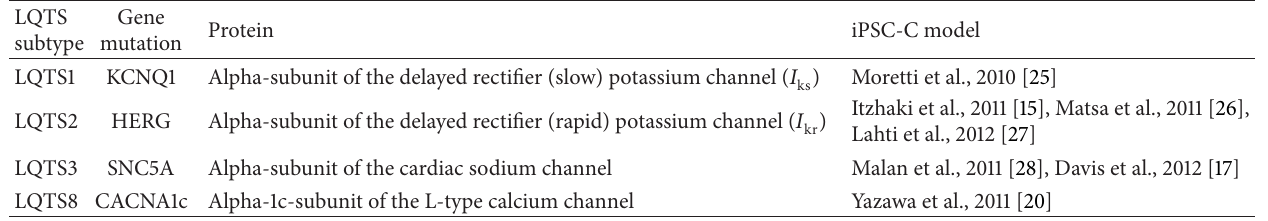
Table 1: Current iPS cell-based models for long QT